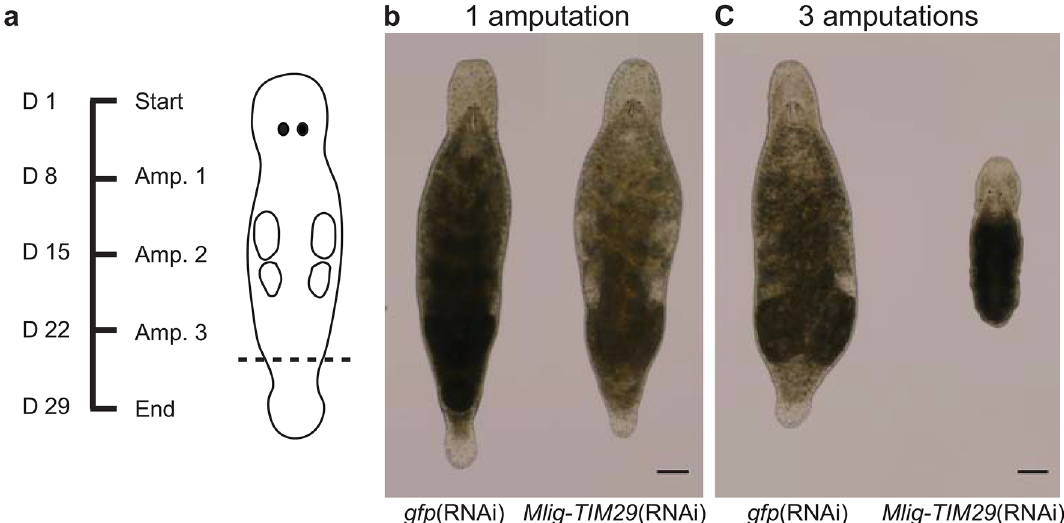
Figure 1. RNA interference screen. ( a ) Experimental design. D represents the time of treatment in days. Amp. describes the number of tail-amputations. The amputation plane is indicated on the worm illustration. ( b ) After a single amputation, worms are able to regenerate the tail within a week. ( c ) After the third amputation of the tail, gfp (RNAi) worms can regenerate, while Mlig-TIM29 (RNAi) worms show a complete lack of regeneration. Scale bars are 100